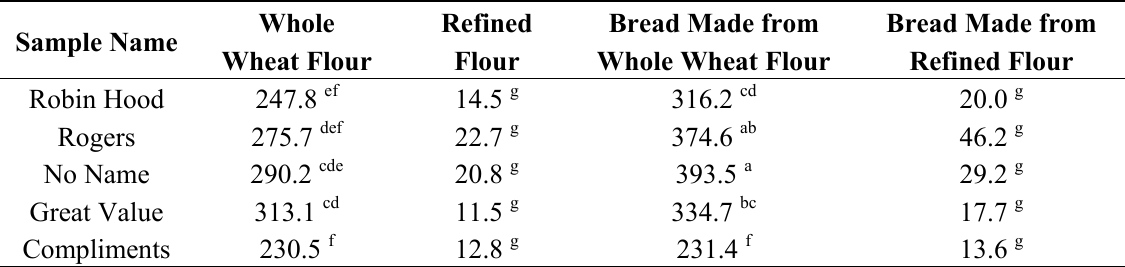
Table 1. Bound ferulic acid content (micrograms of ferulic acid (FA)/g of dry sample) in flour and bread